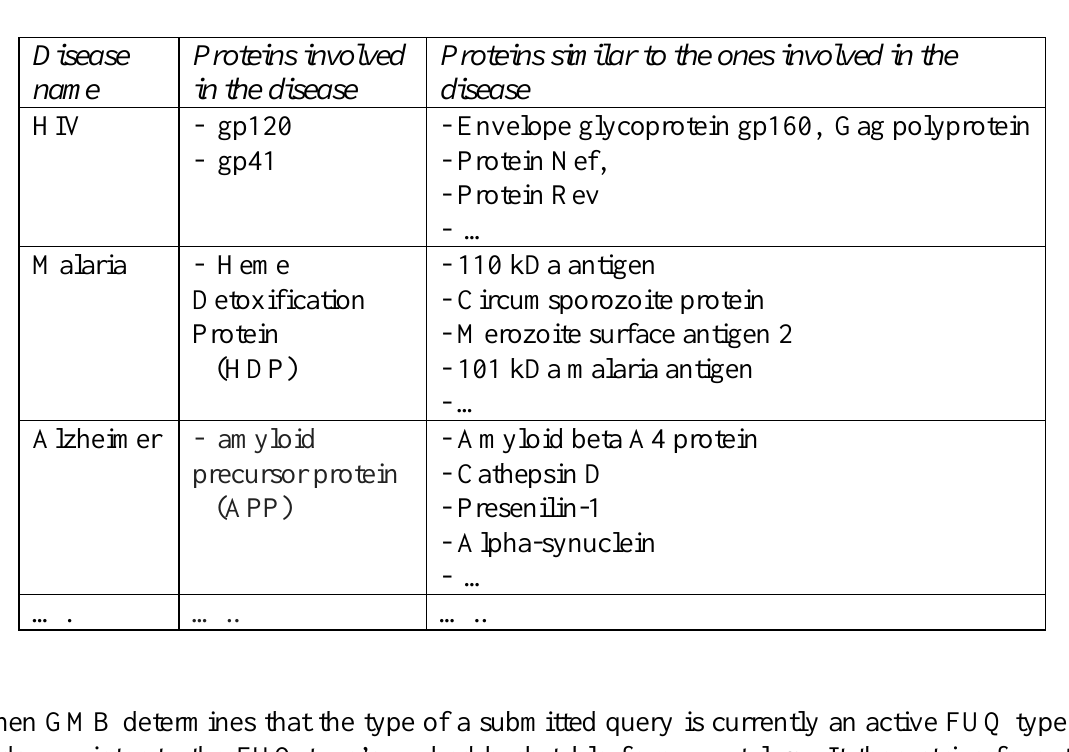
Table 1: A fragment of hash table containing the results of Query Type 5 (Q